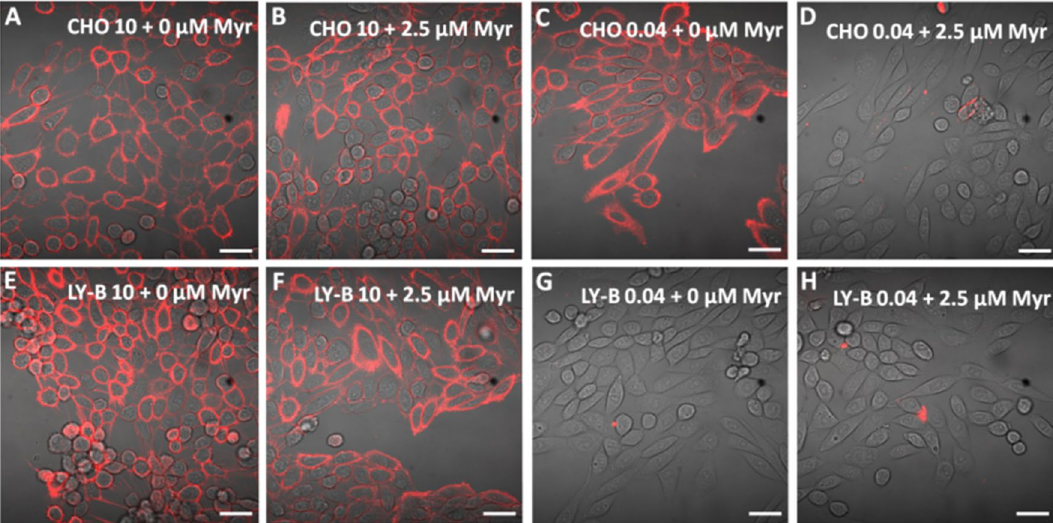
Figure 2. mCherry-Lysenin-stained myriocin-treated or non-treated cells after 72 h growth. Non-treated ( A ) and myriocin-treated ( B ) CHO cells in standard medium. Non-treated ( C ) and myriocin-treated ( D ) CHO cells in deficient medium. Non-treated ( E ) and myriocin-treated ( F ) LY-B cells in standard medium. Non-treated ( G ) and myriocin-treated ( H ) LY-B cells in deficient medium. Bar = 75